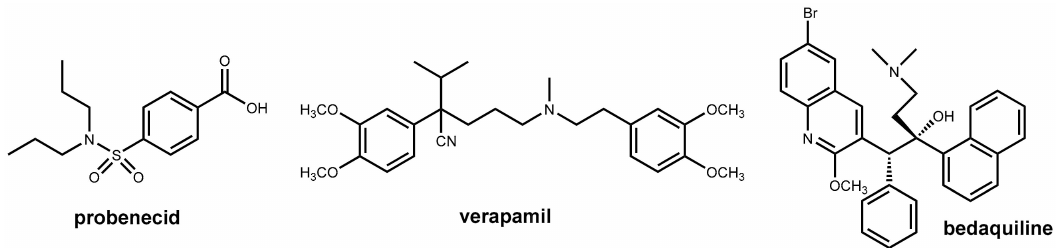
Figure 9. Structures of probenecid, verapamil, and